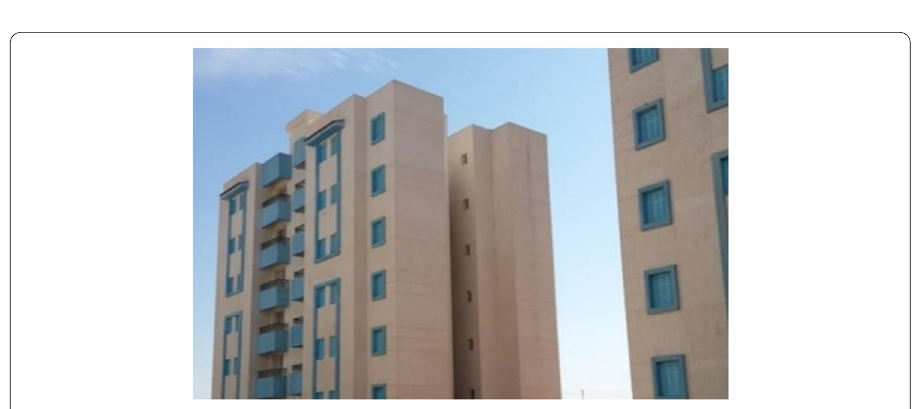
Fig. 3 Governmental housing typologies in Al‑Wadi Al‑Jadid, the western desert